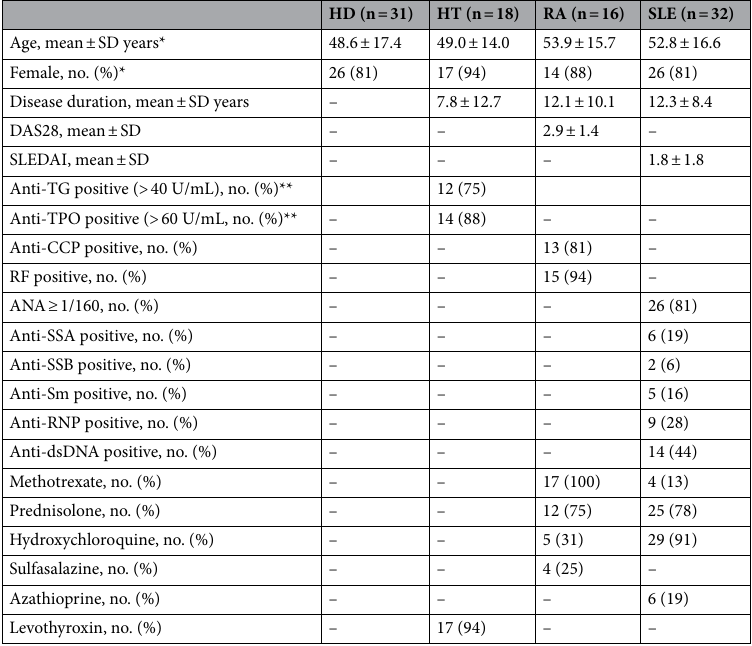
Table 1. Demographic and clinical characteristics of study participants. HD healthy donors, HT hashimoto’s thyroiditis, RA rheumatoid arthritis, SLE systemic lupus erythematosus, DAS28 disease activity score-28, SLEDAI systemic lupus erythematosus disease activity index, Anti-TG anti-thyroglobulin antibodies, Anti-TPO anti-thyroid peroxidase antibodies, Anti-CCP anti-cyclic citrullinated peptides, RF rheumatoid factor, ANA antinuclear antibody. *There were no significant differences against HD controls. **Anti-TG and anti-TPO titers unavailable for 2